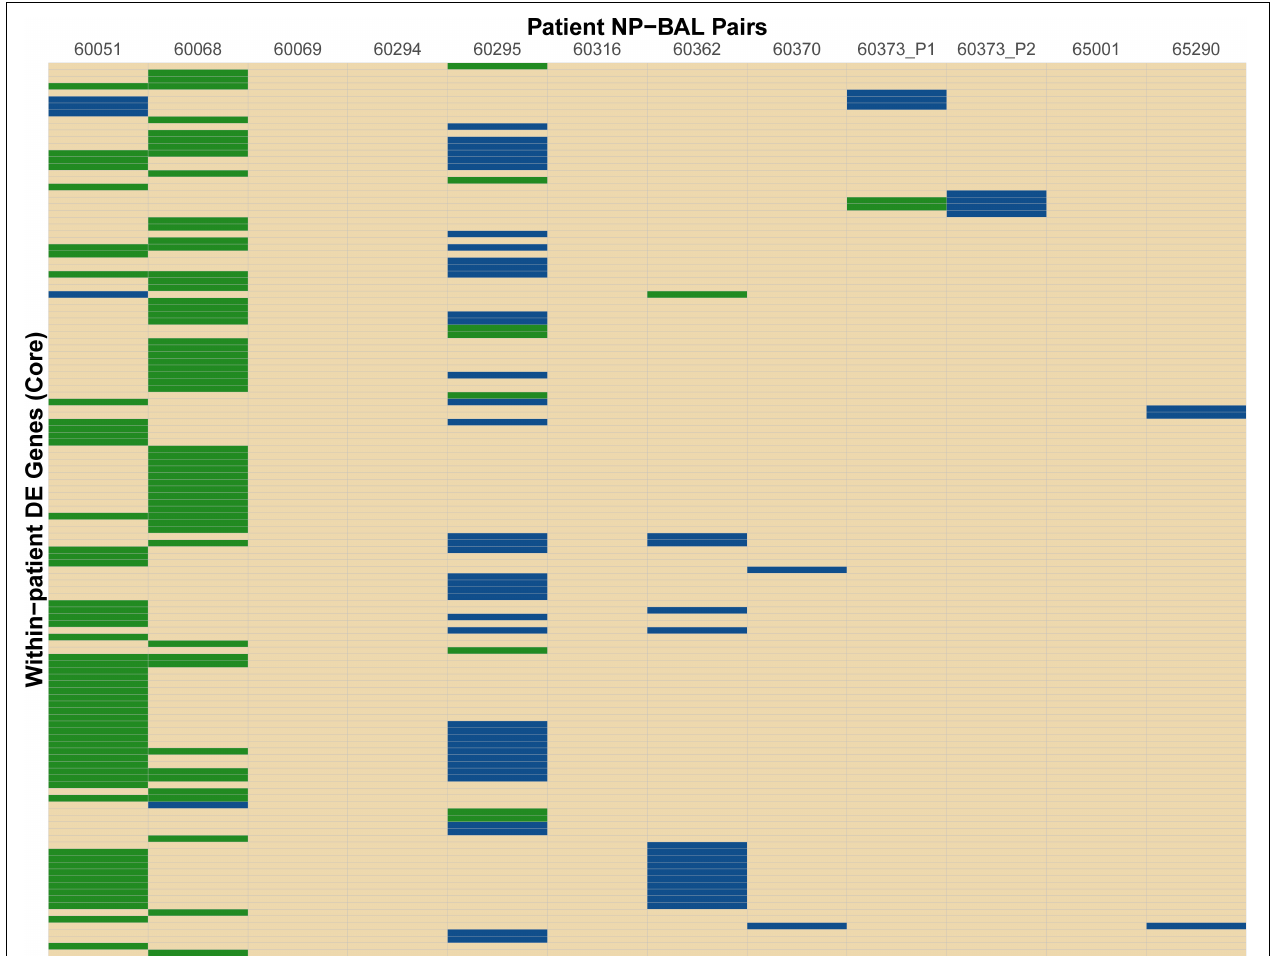
FIGURE 2 | Heat map of differentially expressed (DE) genes identified between the NP-BAL pairs from 11 pediatric chronic lung disease patients. In total 134 non-redundant DE genes were detected across eight NP-BAL pairs. DE was observed in eight NP-BAL pairs; the remaining four pairs contained no DE. Genes were predominantly upregulated in the 60295 NP-BAL pair but predominately downregulated in the 60051 and 60068 NP-BAL pairs. The direction of log 2 fold change of DE genes in BAL is color-coded as follows: upregulation (blue), downregulation (green), no DE